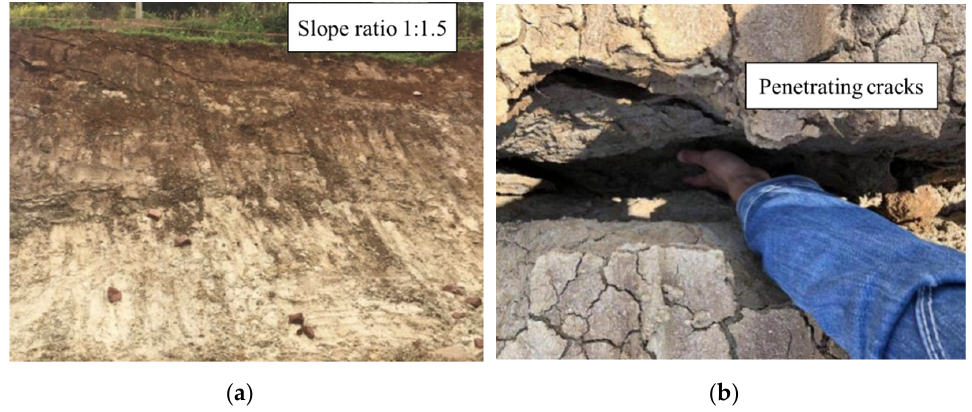
Figure 2. Slope failure problem: ( a ) natural slope with a slope ratio of 1:1.5; ( b ) penetrating cracks that appear under the alternating action of dry and wet conditions.